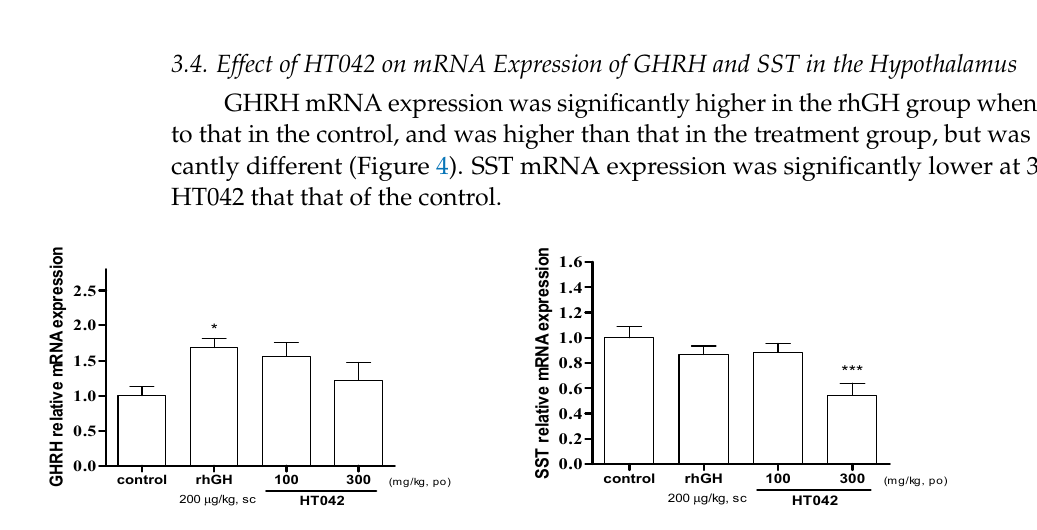
Figure 4. Relative expression of mRNA of growth hormone-releasing hormone and somatostatin in the hypothalamus measured by quantitative real-time quantitative polymerase chain reaction. Data are expressed as mean ± standard error. ( n = 8 per group), * p < 0.05, *** p < 0.001.